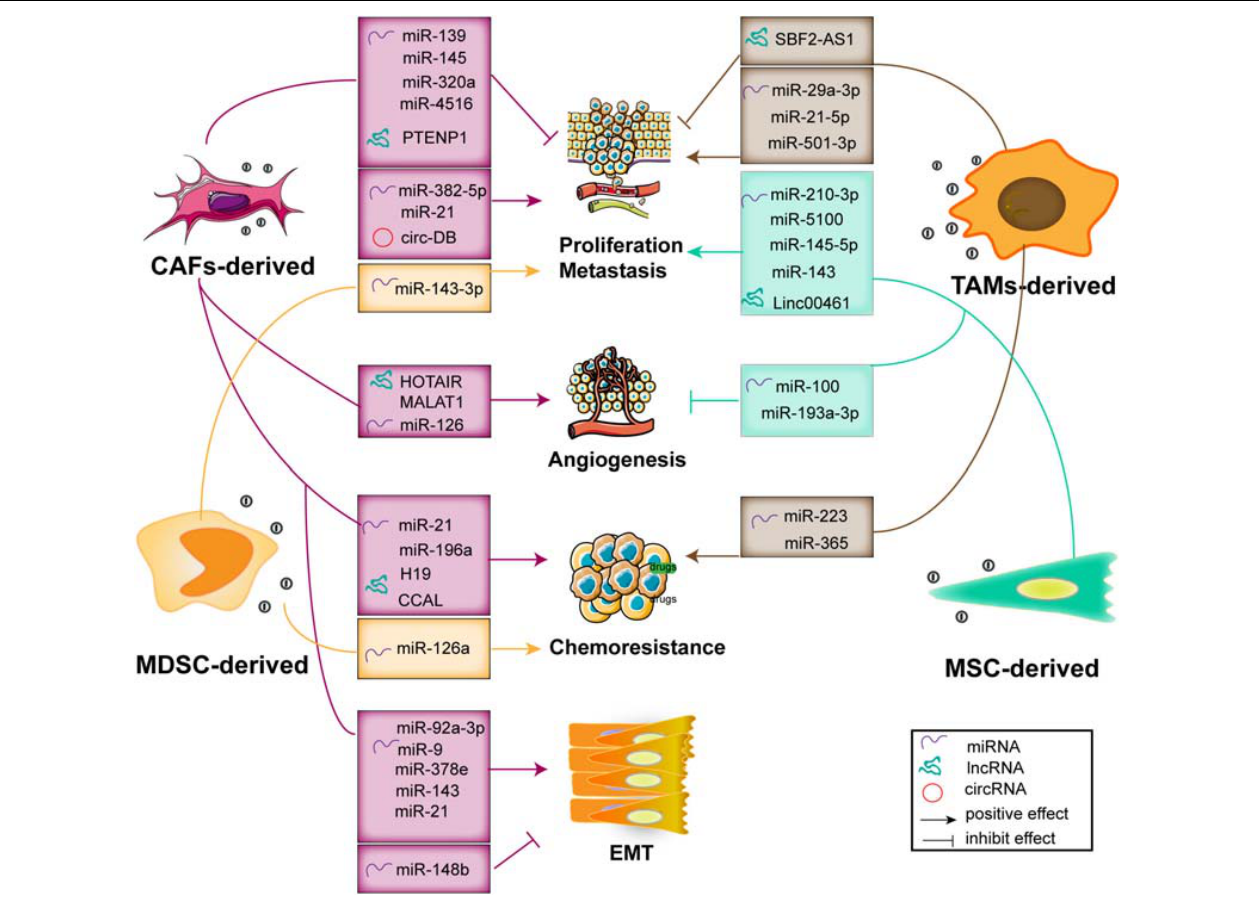
FIGURE 4 | The functions of exosomal ncRNAs derived from stromal cells within the TME contribute to tumor progression and metastasis, angiogenesis, EMT, and